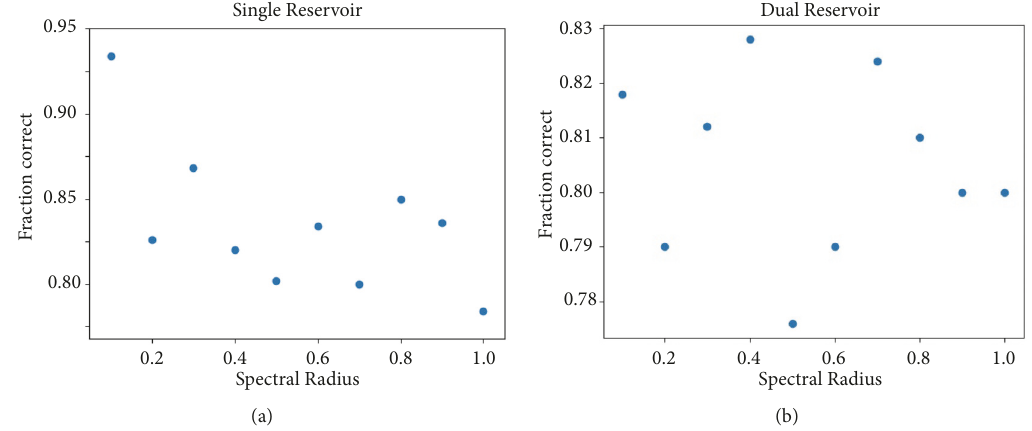
Figure 10: Fractioncorrectas a functionof spectralradius for (a) singlereservoir;(b) dual reservoir. 𝑁 𝑅 =1000;training size=250 pairs; testing size=500 pairs; 𝛾 = 0.5 ; sparsity =